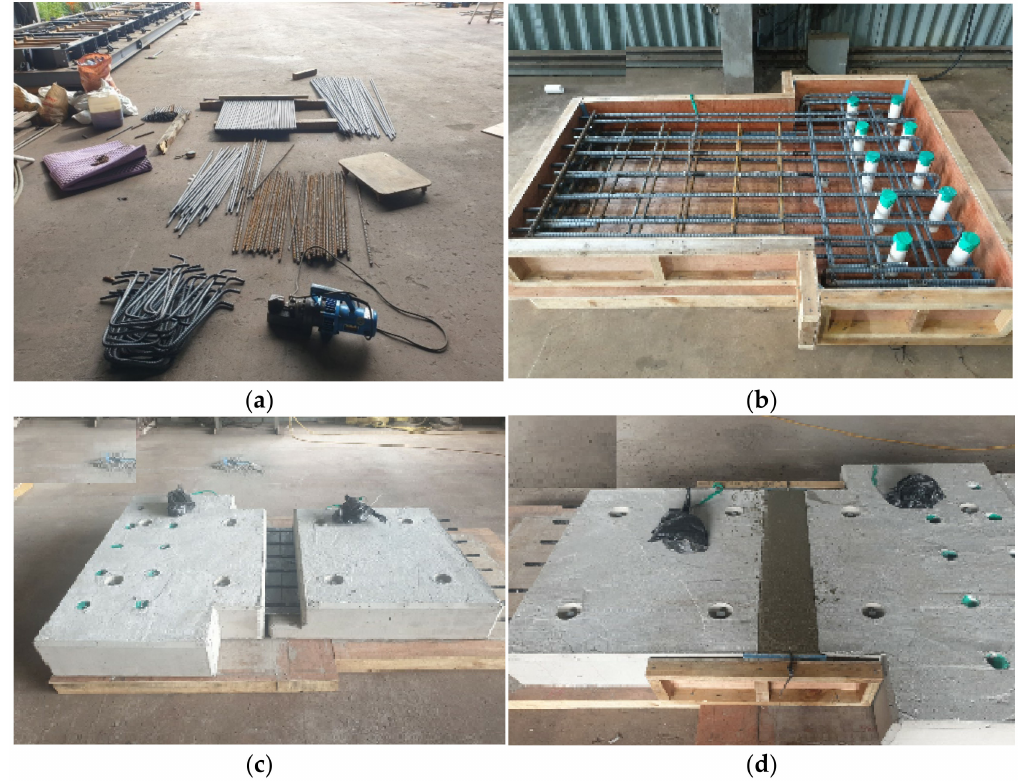
Figure 3. J100-HB-SP fabrication process. ( a ) Fabricating the rebar. ( b ) Assembling the rebar and form. ( c ) Curing specimen concrete. ( d ) Pouring concrete of longitudinal